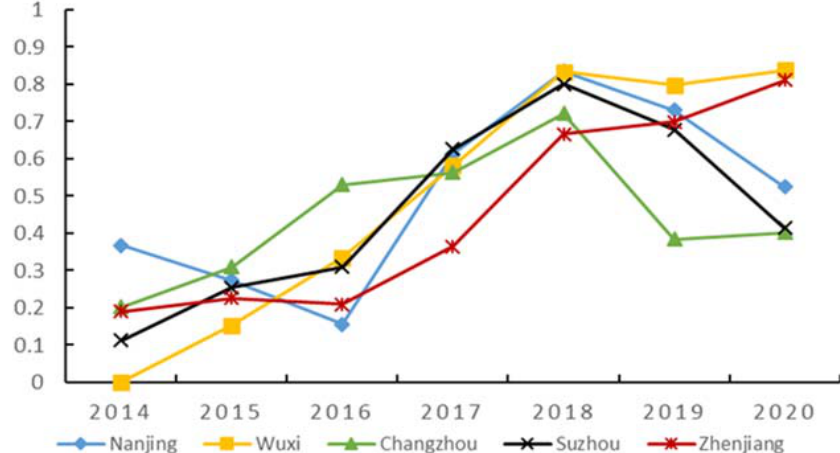
Figure 7. The order degrees of performance supervision subsystems of Taihu Basin among cities during 2014–2020.